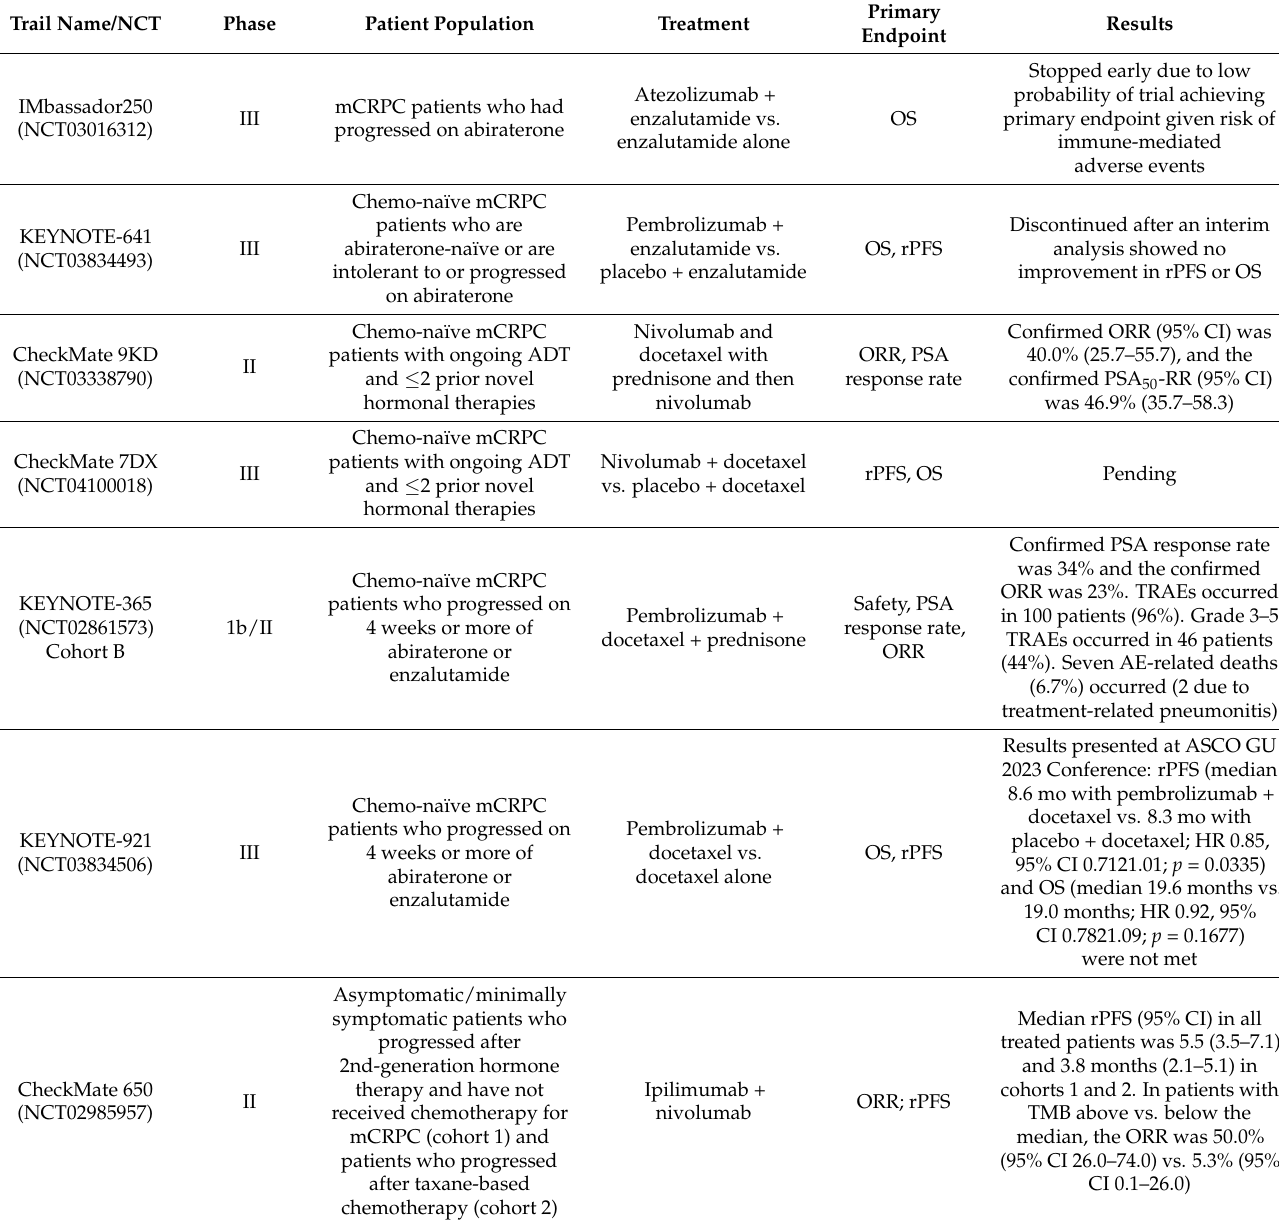
Table 2. Immune checkpoint inhibitor combination therapy evidence in